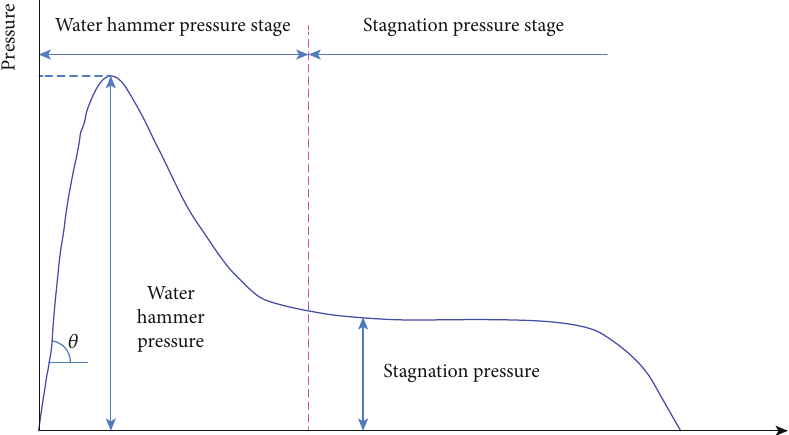
Figure 1: Division of the HPWJ impact pressure